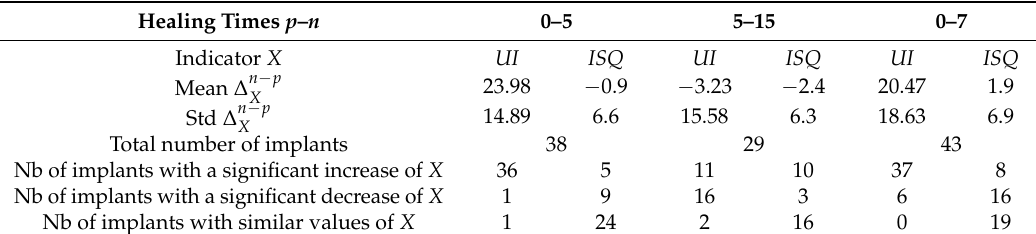
Table 2. Results obtained for the variation of the ultrasonic indicator ( UI ) and of the ISQ when comparing different healing times for all implants considered herein. ∆ n difference of the results obtained for the indicator X between p and n weeks of healing